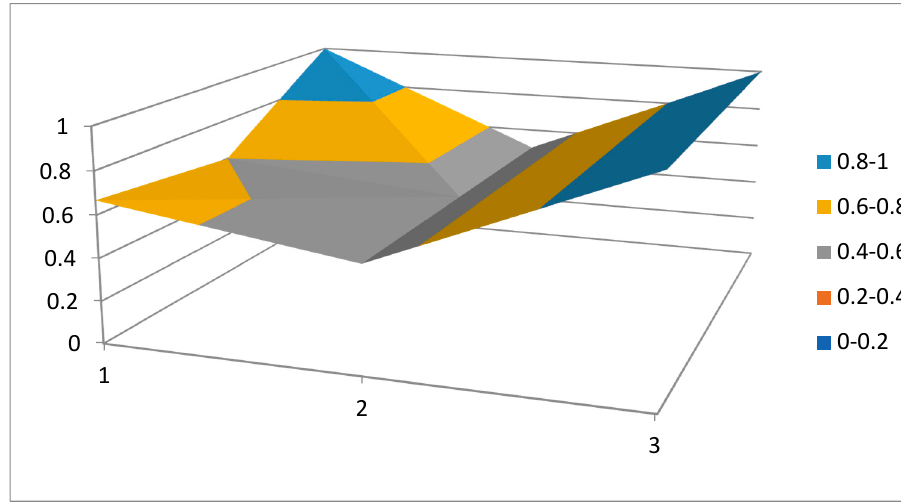
Figure 6. PMC surface of pig price regulation policy P3.